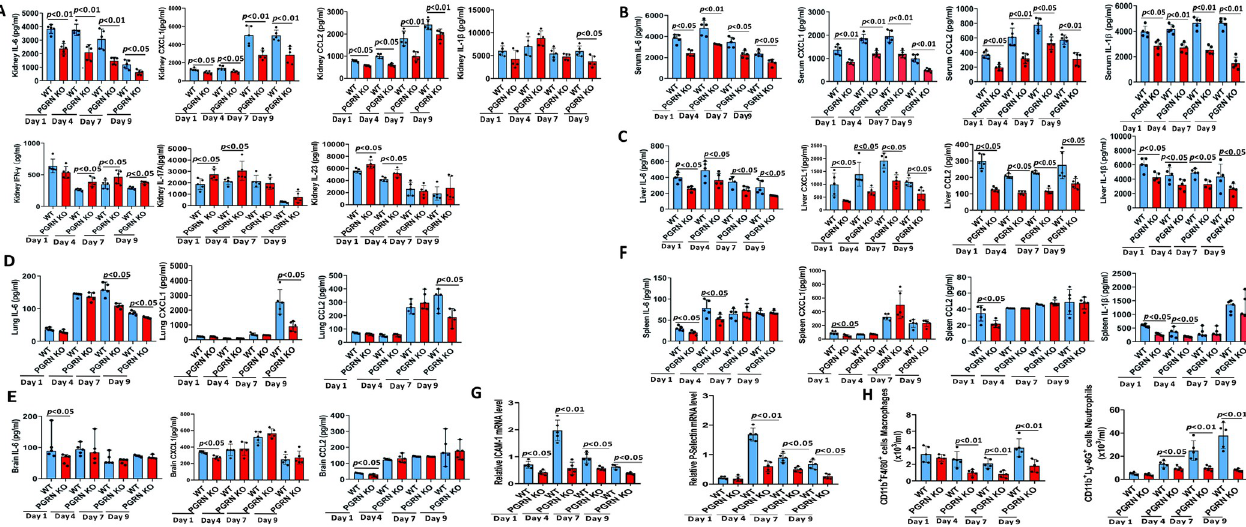
Fig 4. PGRN deletion mediated inflammatory responses in mice after invasive C . albicans infection. PGRN KO (n = 5) and WT (n = 5) mice were infected intravenously with 4 × 10 5 colony forming units (CFU) of C . albicans , and then inflammatory mediators and leukocytes were quantified at the indicated times. (A) Cytokines and chemokines in the kidneys were quantified by enzyme-linked immunosorbent assay (ELISA) at the indicated times after C . albicans infection. (B) Cytokines and chemokines in the sera were quantified by ELISA at the indicated times after C . albicans infection. (C) Cytokines and chemokines in the livers were quantified by ELISA at the indicated times after C . albicans infection. (D) Cytokines and chemokines in the lungs were quantified by ELISA at the indicated times after C . albicans infection. (E) Cytokines and chemokines in the brains were quantified by ELISA at the indicated times after C . albicans infection. (F) Cytokines and chemokines in the spleens were quantified by ELISA at the indicated times after C . albicans infection. (G) Gene expression levels of ICAM-1 and P-Selectin in the kidneys were quantified by quantitative PCR at the indicated times after C . albicans infection. (H) Kidney cells from C . albicans -infected WT and PGRN KO mice were stained with anti-Ly-6G and anti-F4/80 antibodies, and FACS plots in S3 Fig showed the gating strategy for macrophages (CD11b + F4/80 + ) and neutrophils (CD11b + Ly-6G + ). Graphs showed the absolute numbers of macrophages and neutrophils in homogenized kidneys. All data were pooled from three independent experiments. The Mann–Whitney U test was used to analyze the difference between WT and PGRN KO mice at the same time point after C . albicans infection, and p values were shown when compared between groups denoted by horizontal lines.